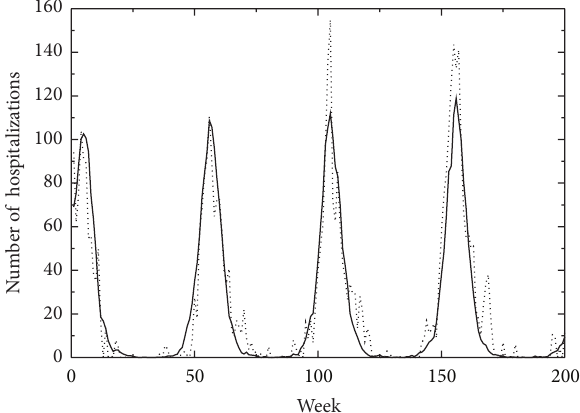
Figure 4: The number of hospitalisations of children under 1 year of age in the Spanish region of Valencia: real data (dotted line) and fitting corresponding to the random network model (solid line). The period of time goes from January 2001 to December 2004.